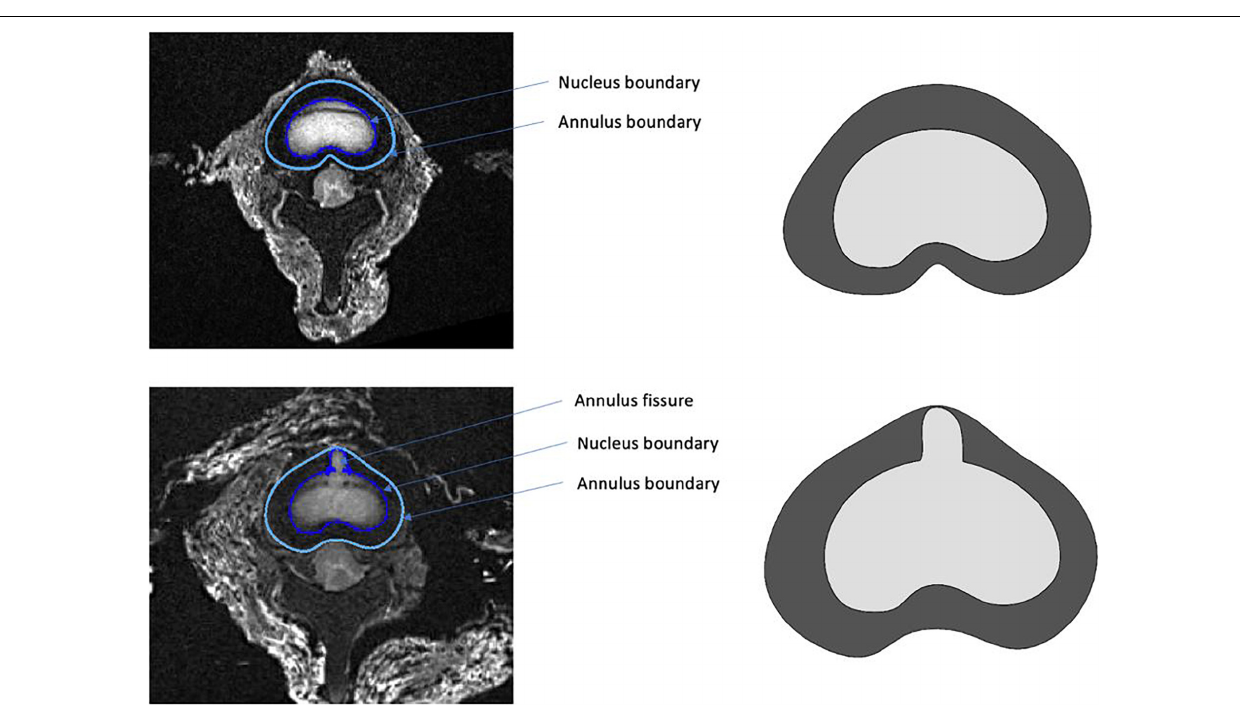
FIGURE 4 | Example of segmentation performed in the intact (top) and fissured (bottom) states, used as input for the finite element